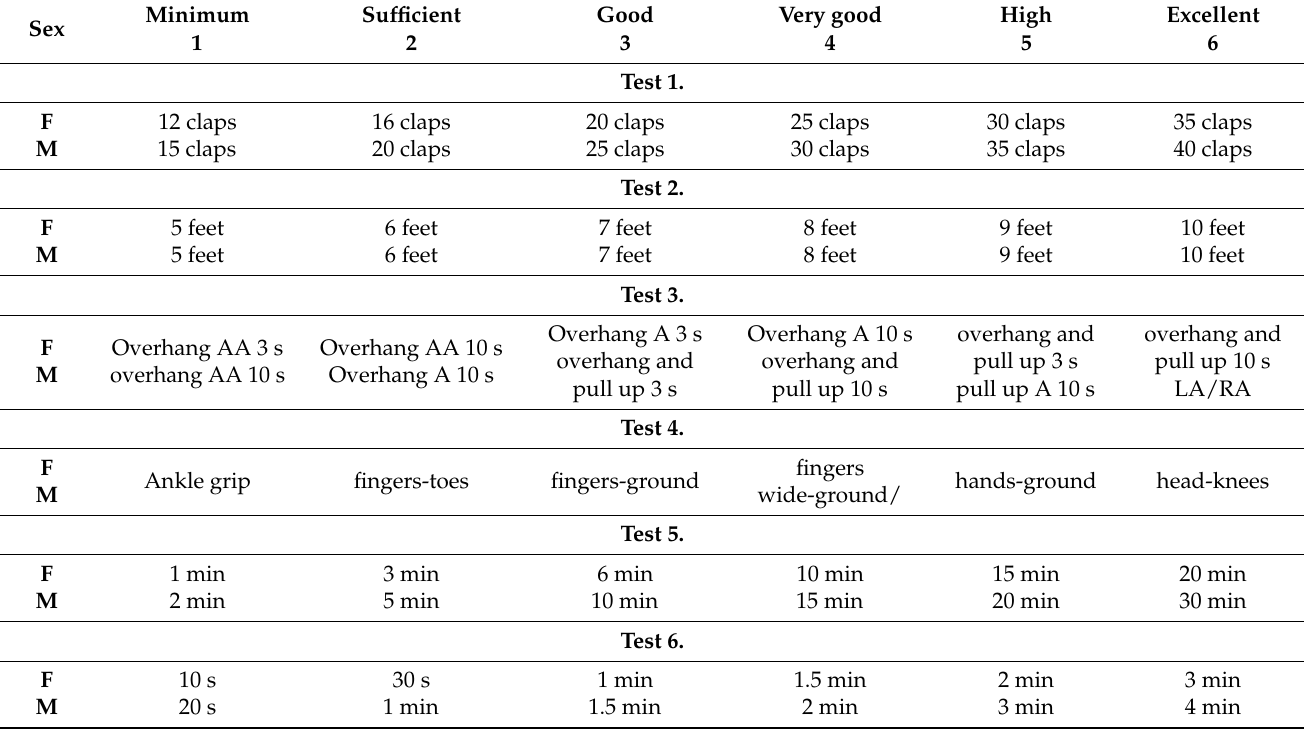
Table 1. The level of the test execution and the score in points.